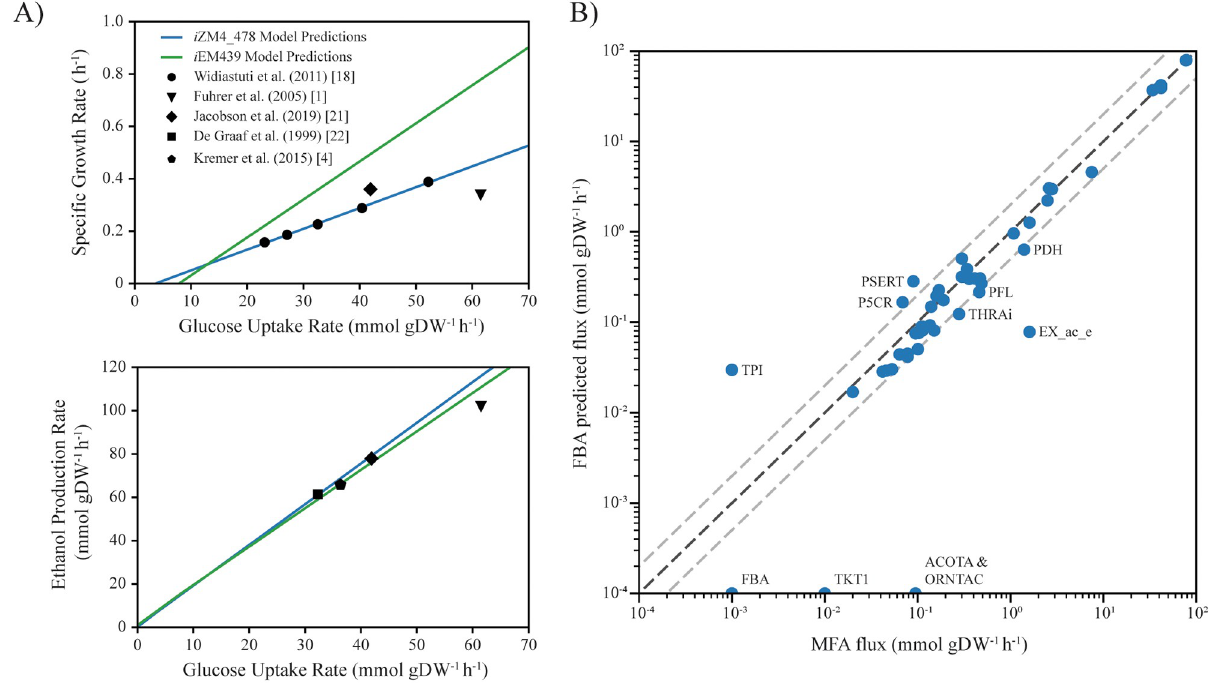
Fig 1. Model predictions for growth, ethanol and central metabolic fluxes. (A) Comparison between model predicted (solid lines) and reported experimental (data points) specific growth rates (top) and ethanol production rates (bottom) against glucose uptake rates for published anaerobic glucose minimal media experiments. Simulation ready models for i ZM363, i ZM411, and i ZmobMBEL601 were not available with their respective publications. (B) Plot of the predicted fluxes based on FBA versus the fluxes found via metabolic flux analysis in Jacobson et al. FBA was run for anaerobic growth in minimal media with a constraint preventing lactate production, forcing flux to ethanol as the primary fermentation product. Flux variability as determined by FVA at the optimal FBA growth rate is less than the size of the markers for each reaction. Grey dashed lines represent a 2-fold change in flux in either direction, reactions falling outside of these boundaries are labeled with their reaction IDs from i ZM4_478 (where ACOTA is acetylornithine transaminase, EX_ac_e is acetate exchange, FBA is fructose-bisphosphate aldolase, ORNTAC is ornithine transacetylase, P5CR is pyrroline-5-carboxylate reductase, PDH is pyruvate dehydrogenase, PFL is pyruvate formate lyase, PSERT is phosphoserine transaminase, THRAi is threonine aldolase, TKT1 is transketolase reaction involving sedoheptulose-7-phosphate, and TPI is the triose-phosphate isomerase). Reactions with zero flux in the FBA solution are plotted at 10 − 4 in the log